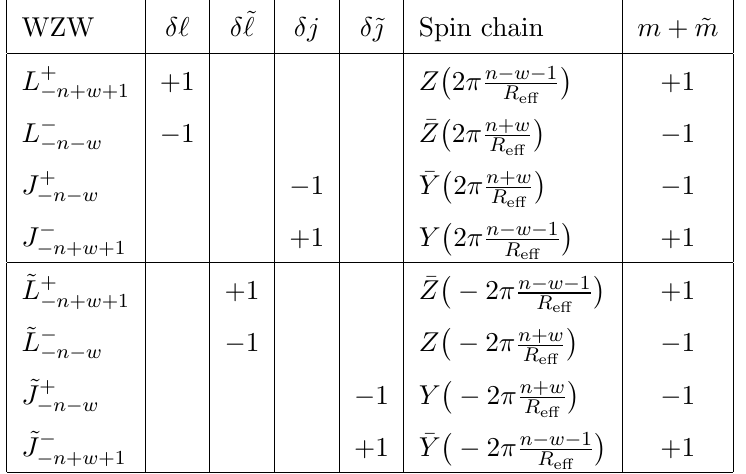
Table 6 . The spin-chain bosonic excitations are matched quite straightforwardly with those in the w -th (cid:13)owed sector of the WZW model. As explained in the text and illustrated in (cid:12)gure 3, it is necessary to shift the mode numbers by (cid:6) w depending on the value of (cid:22) or, in the WZW language, on the charge of the Ka(cid:20)c-Moody current. As a result, it is possible to identify the shifted modes, with n (cid:21)